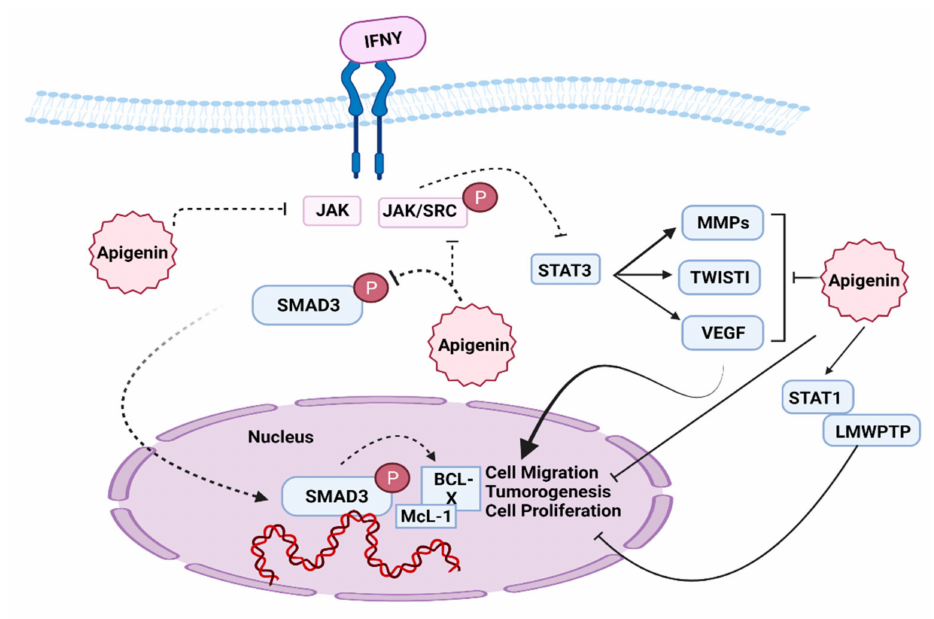
Figure 3. Inhibition of JAK/STAT pathway by